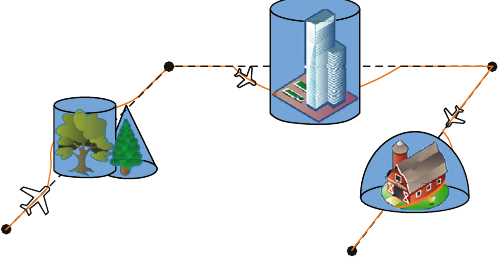
Figure 5: Illustration of UAV avoiding obstacles.